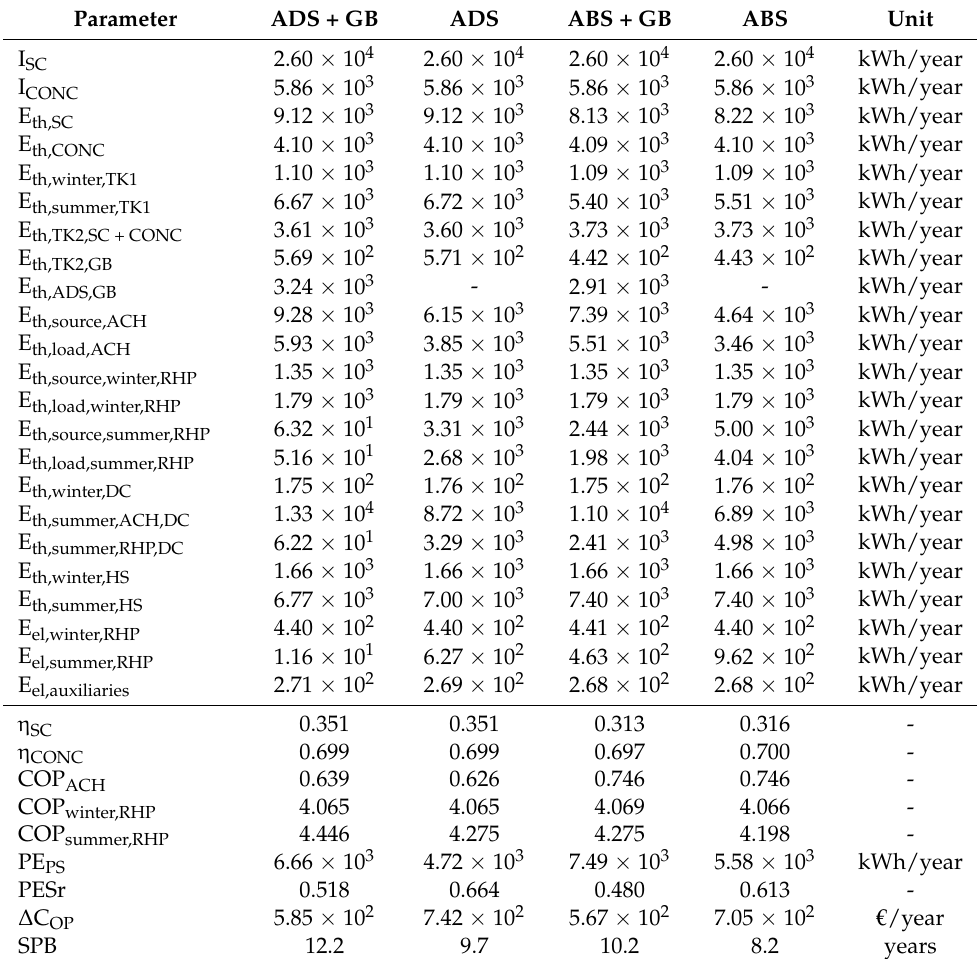
Table 6. Yearly results for Naples